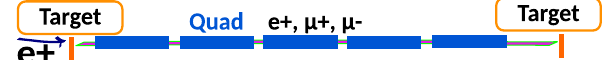
FIG. 2. Schematic diagram of the transport line. Three beams are focused at each target ( μ þ , μ − , and e þ ) to mitigate multiple- scattering while chromaticity is cancelled for the muon